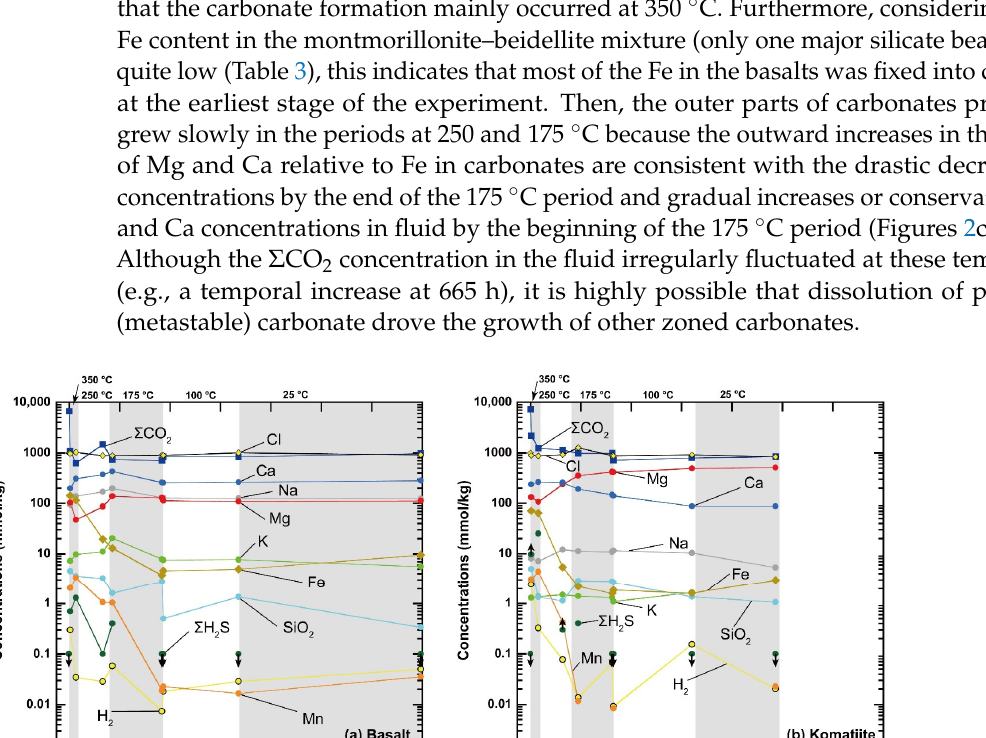
Table 3. Representative compositions of minerals (wt.%) in Exp-B as determined using EPMA. Mineral Montmorillonite-Beidellite Mixture